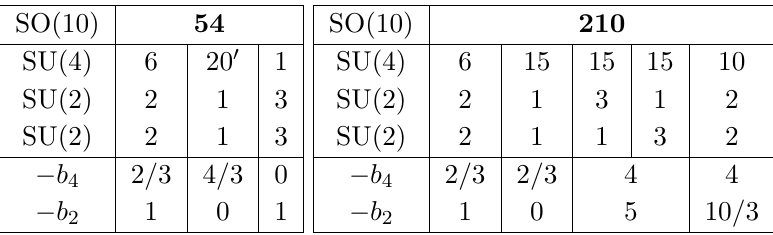
Table 4 . Decomposition of 54 and 210 into representations of 422. For complex representations, complex conjugations of them are